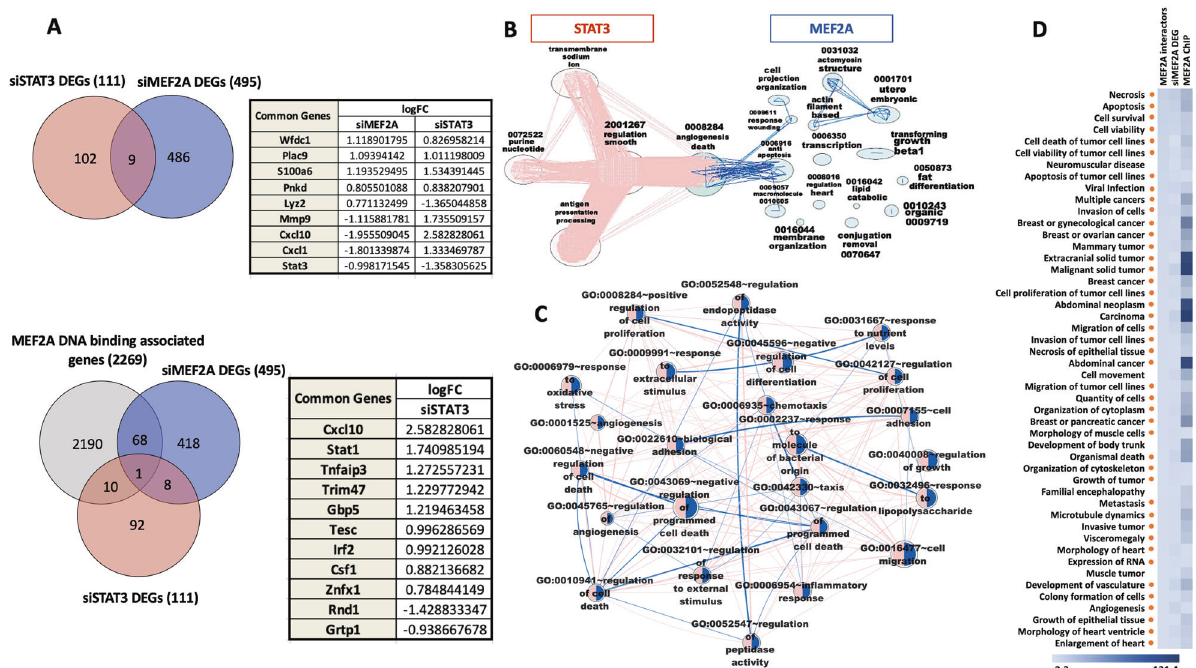
Fig. 6 Comparison between siMEF2A and siSTAT3 datasets. A 9 genes are common between DEGs in siMEF2A and siSTAT3 datasets in PCMs that are indicated in the Venn diagram (Top left). Table represents logFC of the 9 common genes in response to MEF2A and STAT3 depletion in PCMs (Top right). AVenn diagram represents the common genes between the three data sets: MEF2A DNA binding associated genes, siMEF2A DEGs, and siSTAT3 DEGs (Bottom left). Table represents logFC of the 11 common genes between MEF2A DNA binding associated genes and siSTAT3 DEGs (Bottom right). B The enriched GO BP terms for each dataset have been clustered using an Autoannotation plugin in Cytoscape software. The blue clusters identify the speci fi c processes related to MEF2A in PCMs. The red clusters indicate the speci fi c processes related to STAT3 in cardiac cells. The green cluster shows the common processes between MEF2A and STAT3 in primary cardiomyocytes. The edges between clusters show the shared genes between clusters. The cluster size and position are created arbitrarily. C 24 GO BP terms are common between siMEF2A and siSTAT3 datasets in PCMs. The node size represents the gene size. The edge represents the common genes between the terms. Node position and edge length are created arbitrarily. D Integrative analysis of omics data using proteomics, transcriptomics, and ChIP- exo experiments reveals multi-functions of MEF2A in myocardial cells. Three types of omics data have been studied to depict MEF2A gene function in cardiac cells. A Heat map is generated using the three omics technologies and the IPA database used to identify Diseases and Biofunctions that are common in the three omics data. Heatmap indicates the score represented in -log( p -value) for the identi fi ed 48 Diseases and Biofunctions. The red dots beside the map indicate possible involvement of STAT3 in the MEF2A